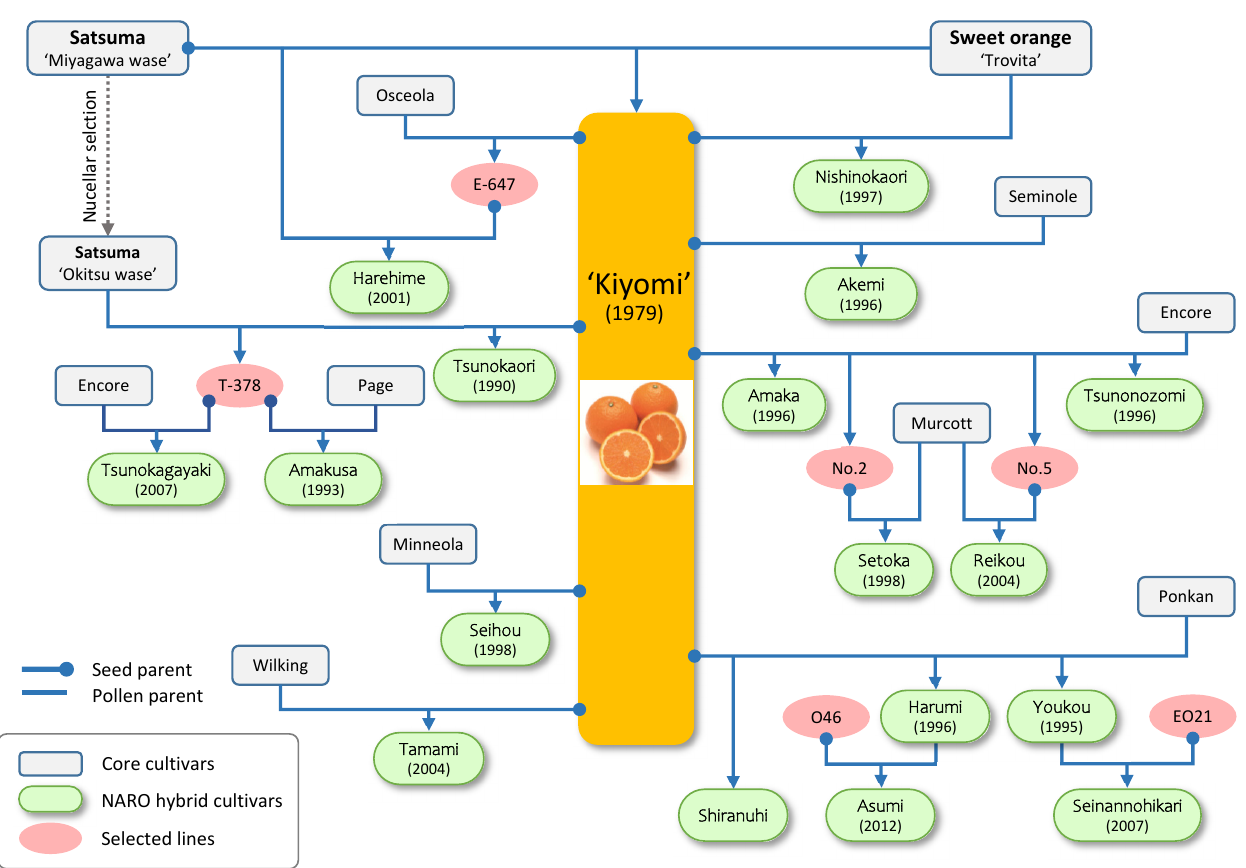
Figure 1. Pedigree tree of ‘Kiyomi’ tangor with its offspring cultivars. Connector line terminating in a circle denotes seed parent, straight end denotes pollen